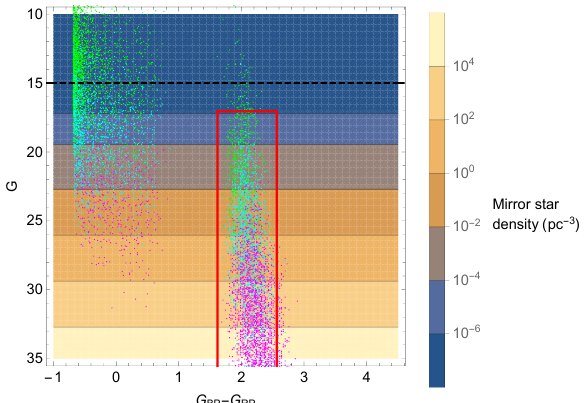
Figure 1. Distribution of our simulated mirror star sample in Gaia’s HR diagram. Green dots: 10 − 10 ≤ (cid:15) ≤ 10 − 11 . Cyan dots: 10 − 11 ≤ (cid:15) ≤ 10 − 12 . Magenta dots: 10 − 12 ≤ (cid:15) ≤ 10 − 13 . The red box is the signal region for our mirror star search in section 3. Horizontal contours indicate the mirror star number density that corresponds to 4 expected mirror star observations in Gaia, corresponding to the abundance that could be excluded by a non-observation in Gaia. The dashed black line indicates the magnitude for which the maximum distance for detection is 100